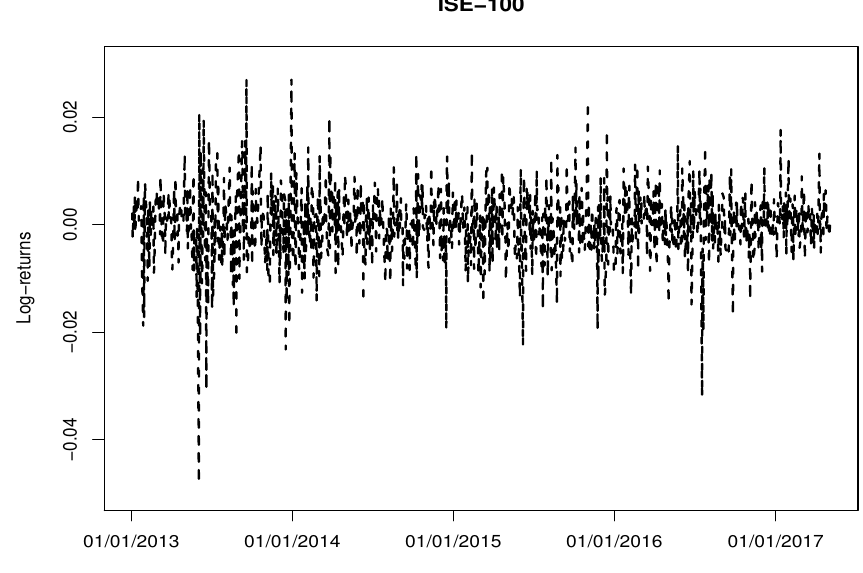
Figure 1. Daily log-returns of the ISE-100